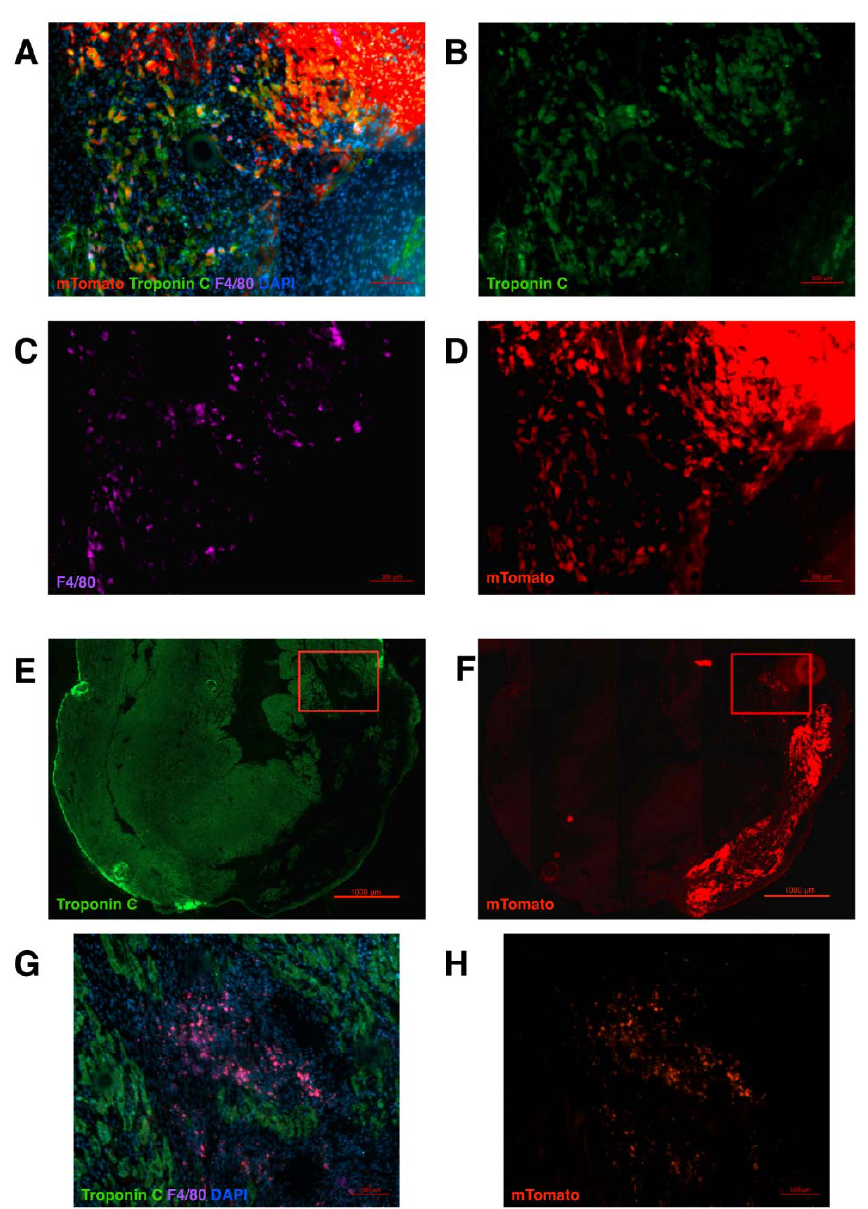
Figure 2. Tissue section analysis 1–2 weeks after the LAA transplantation. ( A – D ) 1 week after transplantation, a large number of cells is observed migrating from the transplant (mTomato = red). Most of the cells are stained with troponin C (green) or with the macrophage marker (F4/80 = magenta). ( E , F ) 2 weeks after transplantation, the LAA transplant (mTomato = red) is solidly integrated to the left ventricle. Some of the transplant ‐ originated cells express troponin C (green). ( G , H ) Clusters of small transplant ‐ originated cells are seen in the infarct zone further away from the transplant (magnification from the red frame in E and F ). Migrated cells co ‐ express F4/80 (magenta) with mTomato (red). DAPI = blue.